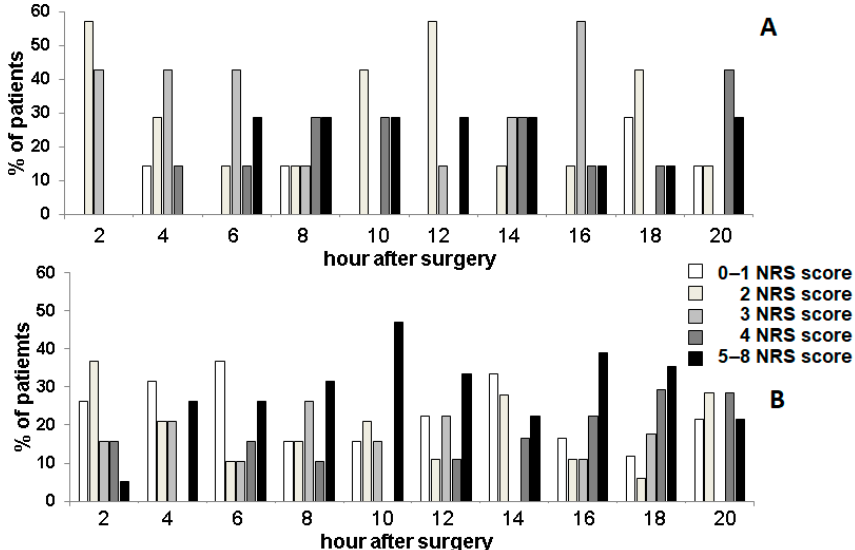
Figure 1. Assessment of pain according to the NRS scale in patients undergoing spinal deformity correction. ( A ) – study group, ( B ) – control group. In a longer time of observation, the pain scores were distributed to all five categories in both groups (data not shown).